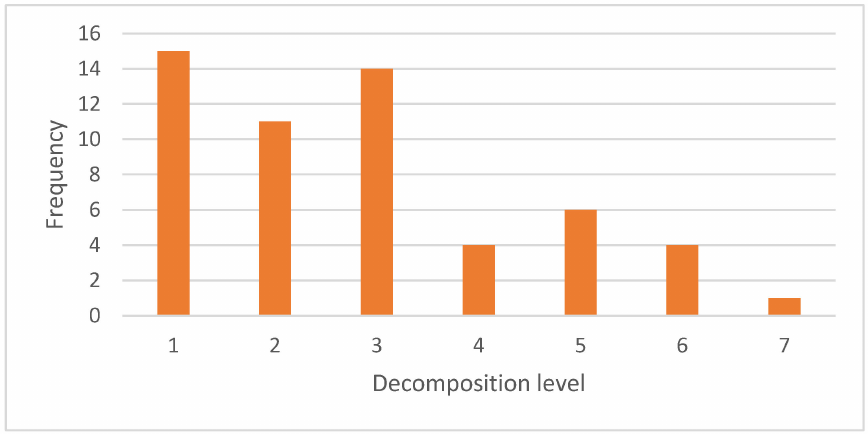
Figure 6. Frequency of selection of each decomposition level at each node of the GPCR